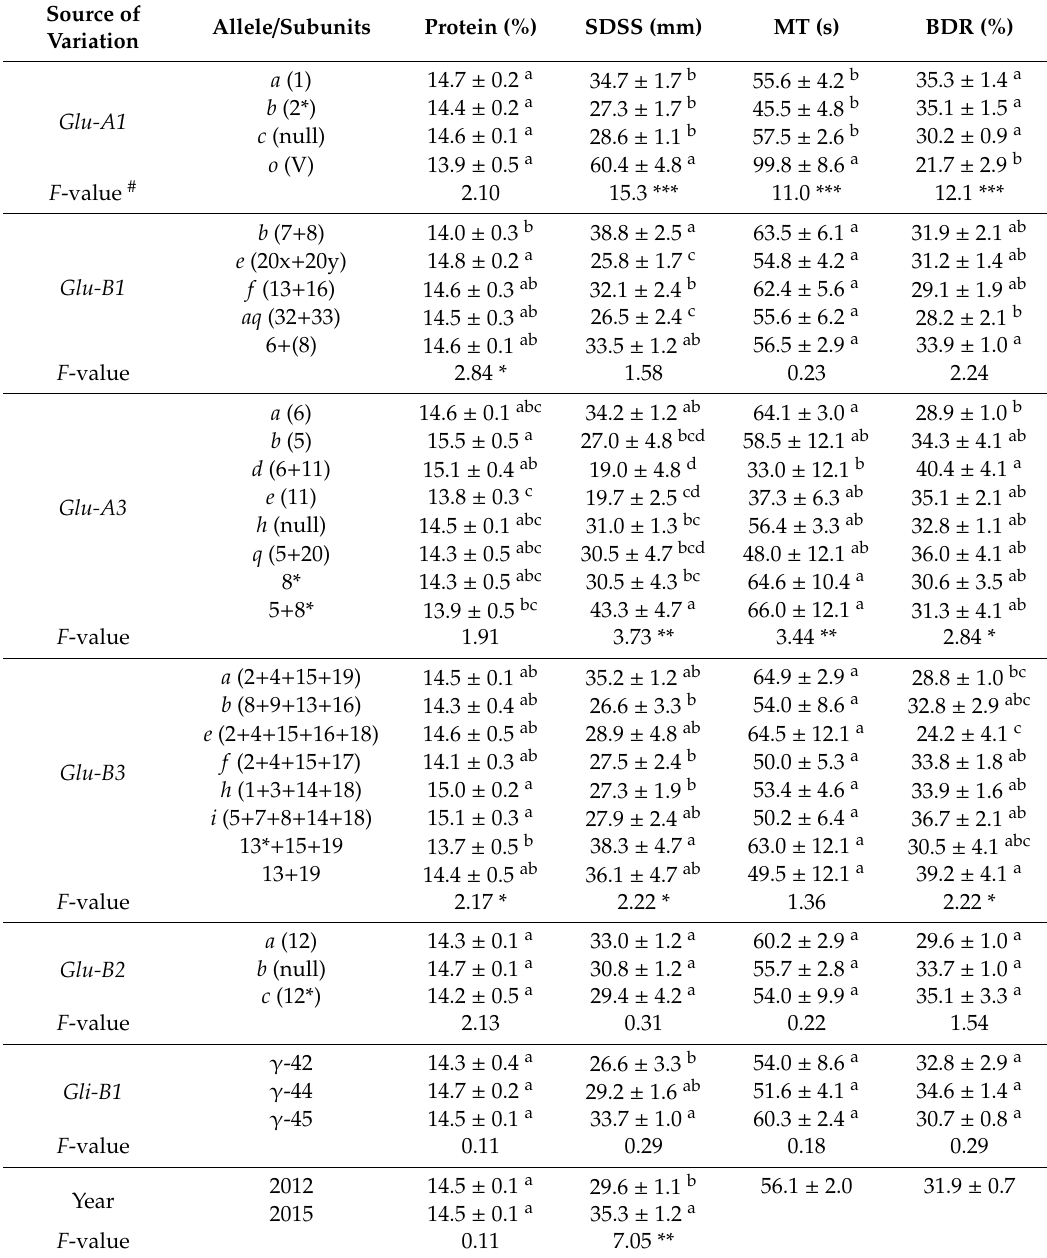
Table 2. ANOVA F-values testing the e ff ect of the prolamin loci on the quality traits analyzed. The e ff ect of the year is also considered for protein content and SDS sedimentation volume. The results of the Duncan’s multiple comparison of means are